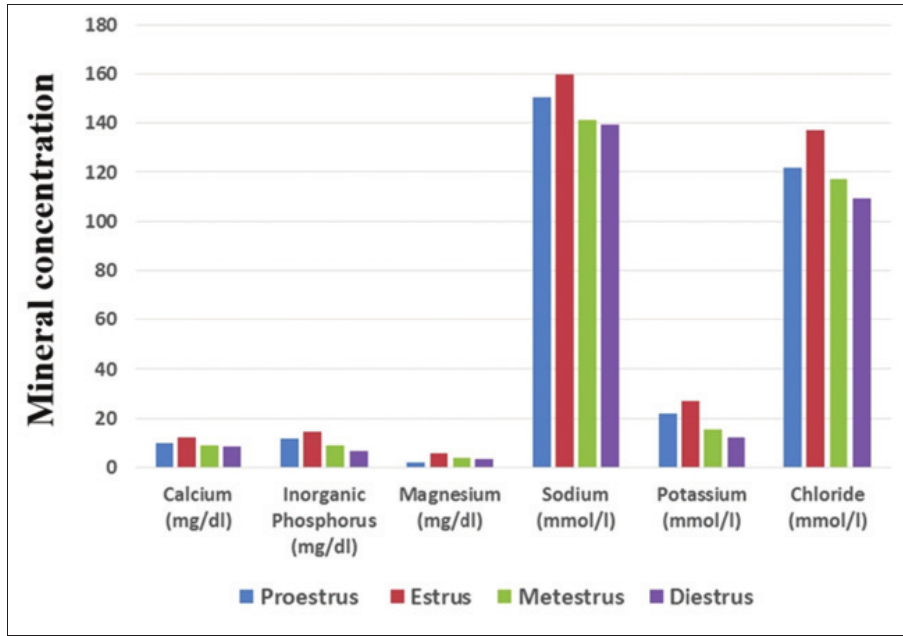
Figure-1: The salivary electrolytes concentration during estrous cycle in Murrah buffaloes. Table-2: Mean±SE values for blood plasma hormones levels during different phases of estrous cycle in Murrah buffaloes. Hormones